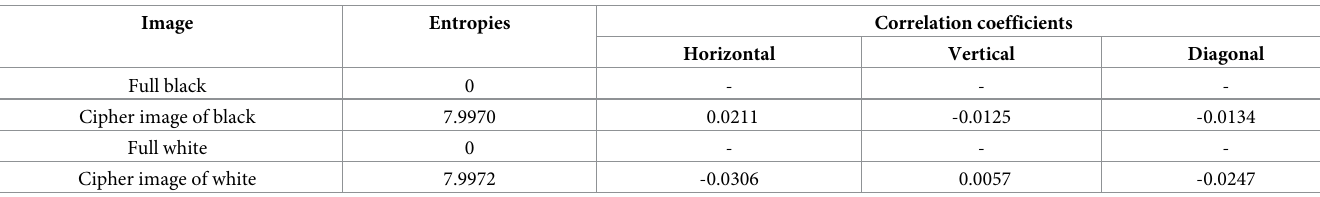
Table 6. Black and white correlation coefficient and